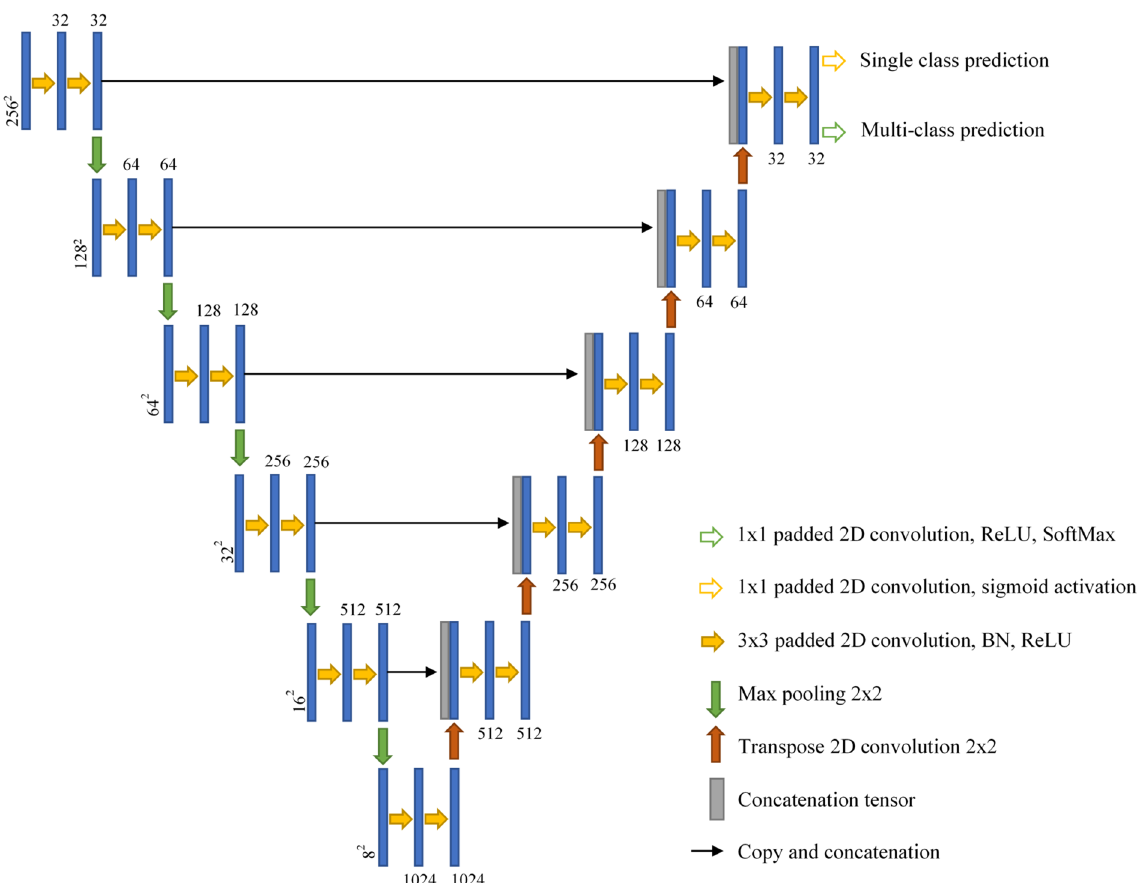
Figure 6. U-Net architecture using padded convolutions for both single class and multiclass